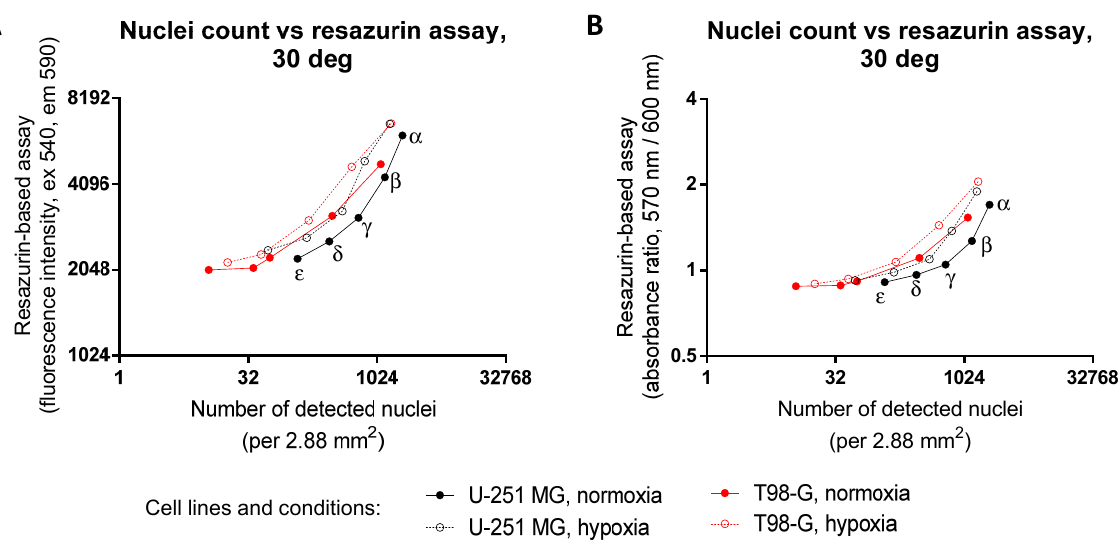
Figure 7. Comparison of data reflecting cellular viability measured using the detection of both metabolic activity and the number of nuclei following normoxic vs. hypoxic treatment of glioblastoma cell lines at 30 °C. Y-scale, the resazurin assay; X-scale, the microscopy assay; cell line names indicated under the graphs. Different initial seeding densities were used (for better visualization, indicated for the right-most curve only: α , 12,500 cells per well; β , 6250 cell per well; γ , 3130 cell per well; δ , 1560 cells per well; ε , 780 cells per well). For hypoxic treatment, cells were kept in the hypoxic chamber (1% O 2 ) for 72 h prior to measuring the viability (at 96 h post-seeding). In the resazurin assay, measurements were carried out at 50 μ M resazurin; fluorescence intensity (excitation at 540 nm) was detected in ( A ) (after 45 min incubation with resazurin) and absorbance ratio (570 nm/600 nm) in ( B ) (after 60 min incubation with resazurin). The nuclei were counted in 25 fields of view (dimensions of one field of view: 292 μ m × 395 μ m) using an automatic detection algorithm based on DAPI staining. Please note that the axes are logarithmic. In each graph, the average of triplicates from a single representative resazurin and a single representative microscopy experiment is shown; for better clarity, vertical and horizontal error bars were omitted.